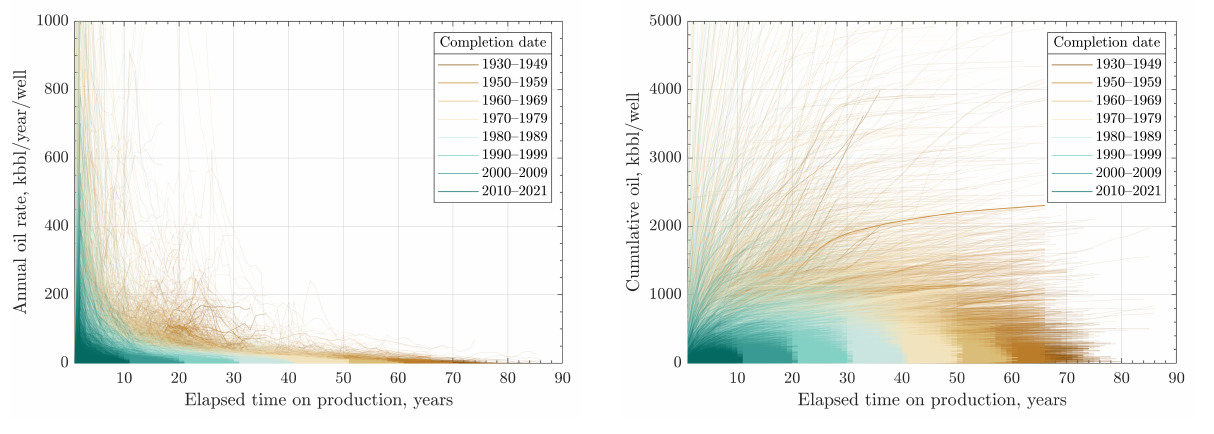
Figure 1. ( a ) Annual oil rate in kbbl/yr and ( b ) Cumulative oil in kbbl from all 484,759 vertical wells in the Permian